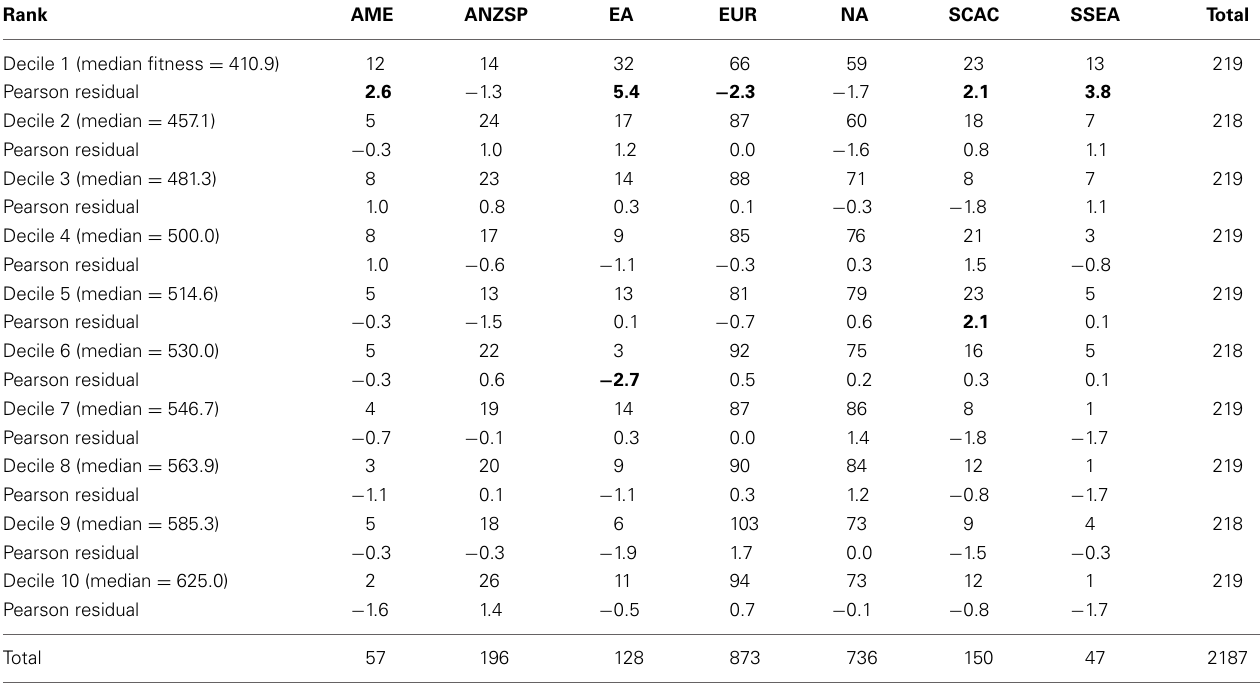
Table 8 | Contingency table of residuals from Pearson χ 2 tests comparing respondents’ fitness level (decile) by region of residence.